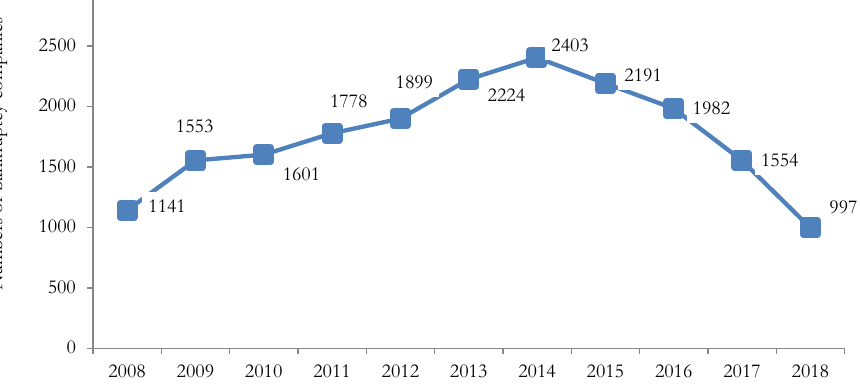
Fig. 1 – Numbers of bankruptcy companies in the Czech Republic in the years 2008-2018. Source: Crefoport